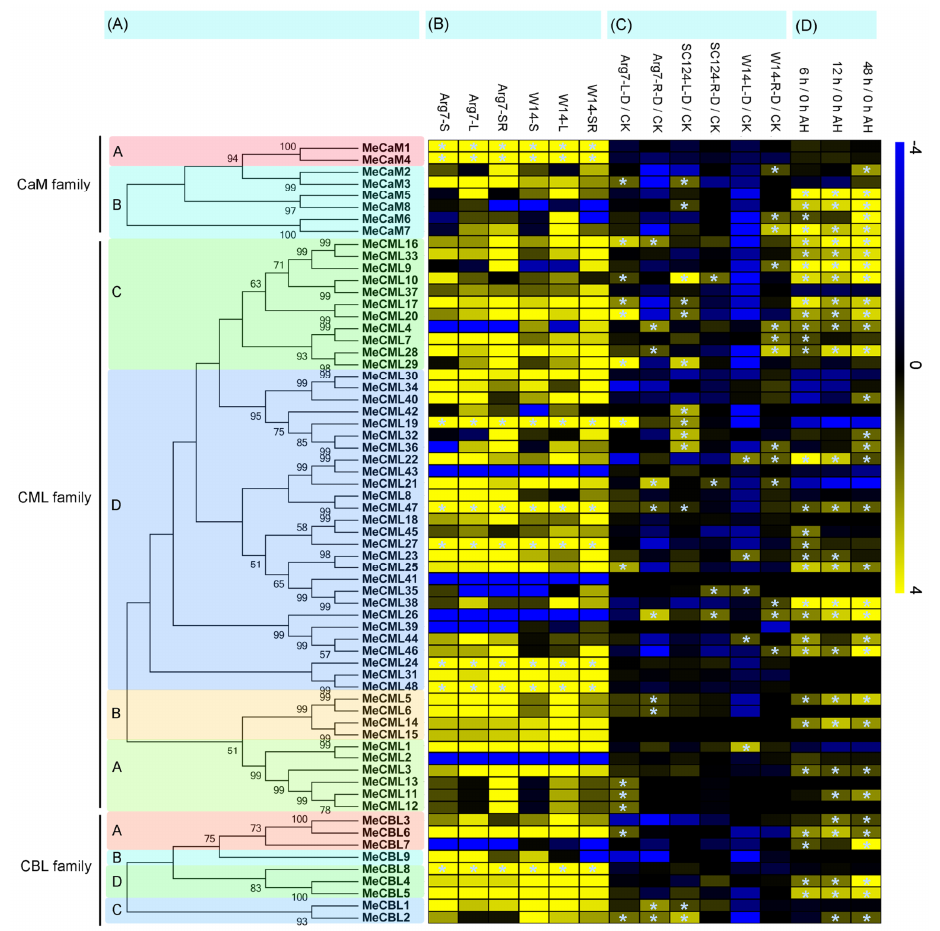
Figure 4. Expression profiles of CaMs, CMLs, and CBLs in cassava, according to phylogenetic relationship. ( A ) Phylogenetic relationship of cassava CaMs, CMLs, and CBLs. ( B ) Expression profiles of cassava CaMs, CMLs, and CBLs in stems (90-day-old), leaves (90-day-old), and storage roots (150-day-old) of Arg7 and W14. Asterisks indicate the genes that show high expression levels (Log 2 based fragments per kilobase of transcript per million fragments mapped (FPKM) > 5) in all the tissues examined. S, stem; L, leaf; SR, storage root. ( C ) Expression profiles of cassava CaMs, CMLs, and CBLs in response to drought stress in leaves and roots of Arg7, SC124, and W14. Ninety-day-old cassava plants were subjected to water withholding for 12 days, and leaves and roots were collected for RNA-seq. Asterisks indicate the genes that are induced (Log 2 based fold changes > 1) after drought treatment. L, leaf; R, root; D, drought treatment; CK, control check showing leaves or roots of cassava varieties under normal conditions. ( D ) Expression profiles of cassava CaMs, CMLs, and CBLs in cross-sessions of SR at 6 h, 12 h, and 48 h compared with 0 h after harvest. Ten-month-old storage roots were cut into slices approximately 5 mm thick, and then were moved into petri dishes containing a wet filter paper. After incubation at 28 °C and 60% relative humidity in the dark for 0 h, 6 h, 12 h, and 48 h, the slices were sampled for RNA-seq. Asterisks indicate the genes that is induced (Log 2 based fold changes > 1) after harvest. AH, after harvest. Log 2 based FPKM ( B ) or fold change ( C ) and ( D ) was used to create the heat map. Changes in gene expression are shown in color as the scale.